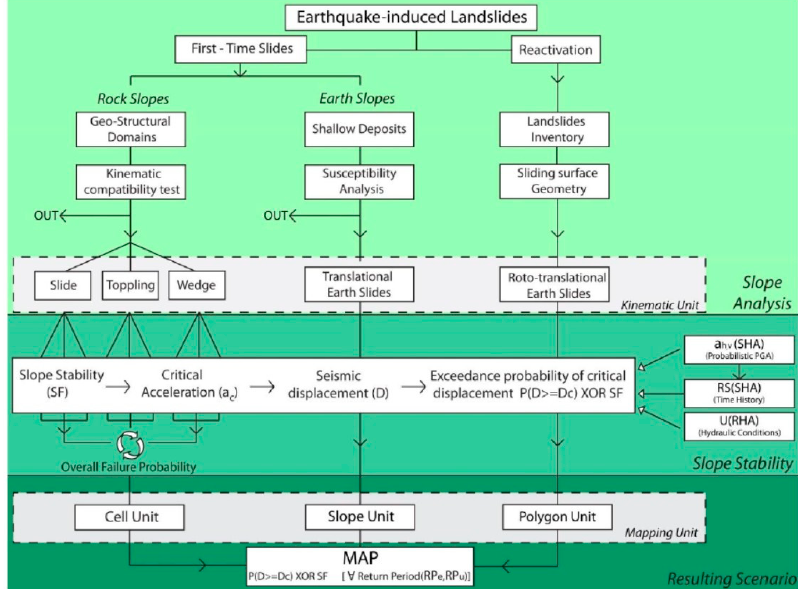
Figure 1. Flow chart illustrating the 3 steps procedural scheme of the (Probabilistic Approach to pRovide Scenarios of earthquake-Induced slope FAiLures) PARSIFAL.